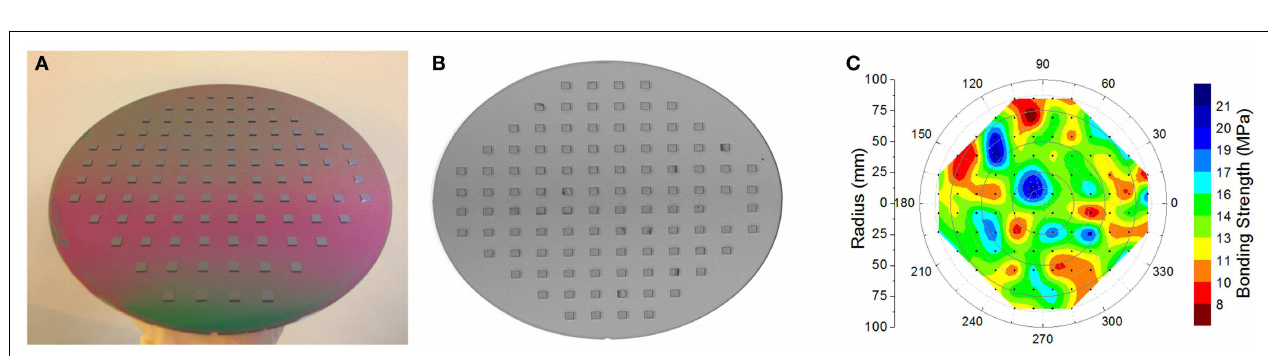
0.182 nm,which is far below the required RMS of < 1 nm for wafer direct bonding (Christiansen et al.,